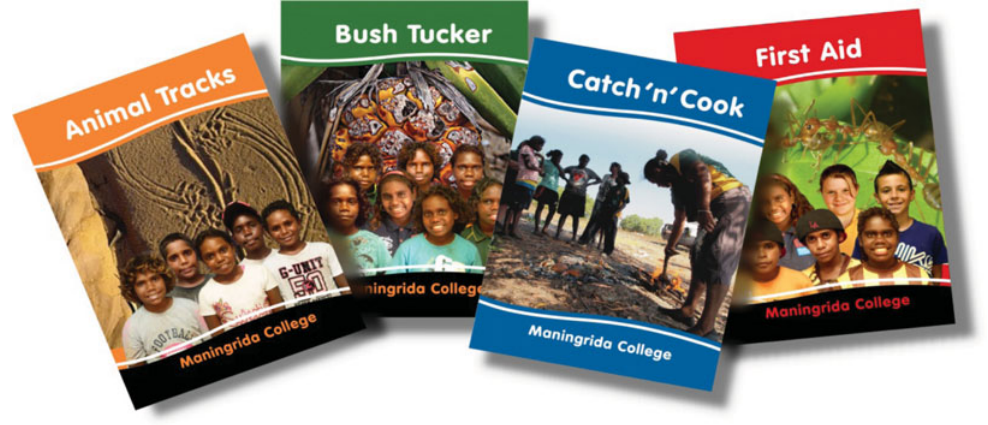
(Colour online) Pocket Book